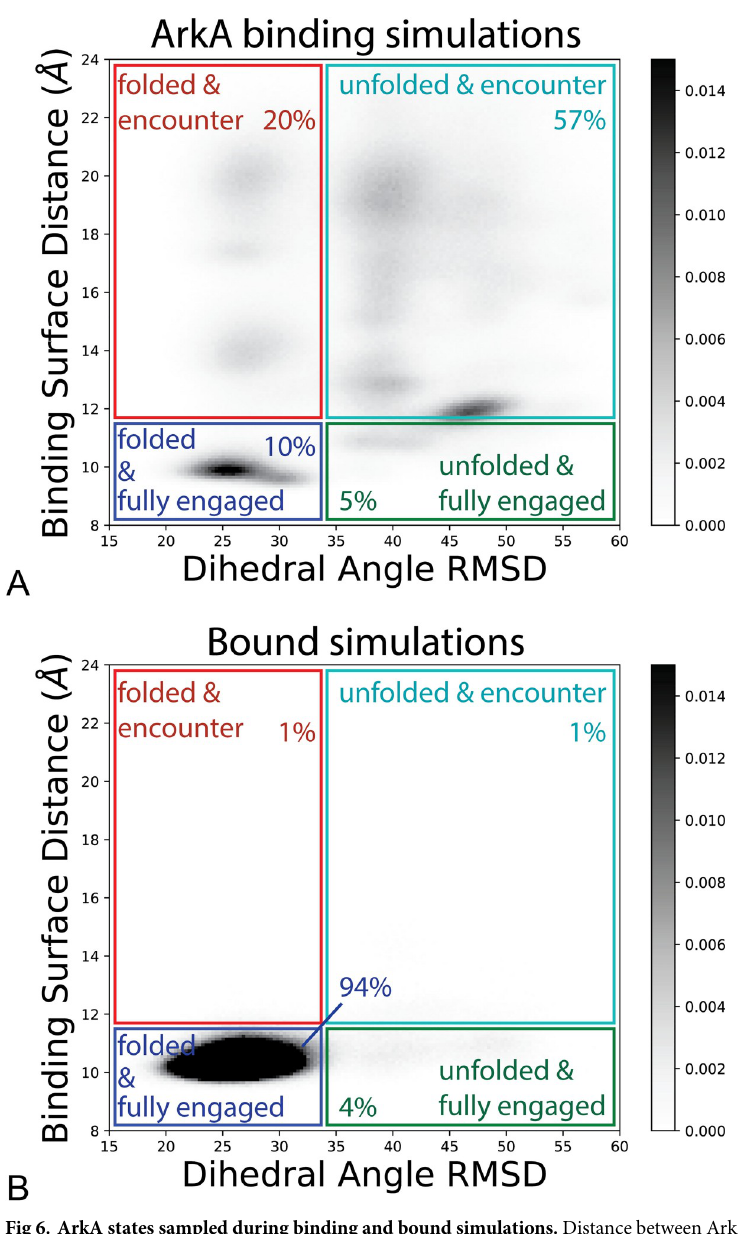
Fig 6. ArkA states sampled during binding and bound simulations. Distance between ArkA and the binding surface of AbpSH3 graphed against the ArkA backbone dihedral angle RMSD for ArkA binding simulations (A) and bound simulations (B). Darker shading indicates a larger fraction of the total ensemble, as indicated by the color bar. Colored boxes partition the ensemble into four states: folded and fully engaged (blue), unfolded and fully engaged (green), folded and encounter (red), unfolded and encounter (cyan). In this figure, folded refers to the native NMR structure fold (dihedral RMSD less than 33.7˚), and unfolded refers to a nonnative conformation different from the NMR fold (dihedral RMSD greater than 33.7˚). Percentages indicate the occupancy of each state in the overall simulated ensemble. In the ArkA binding simulations, 8% of the ensemble is in the unbound state, which is not shown on the